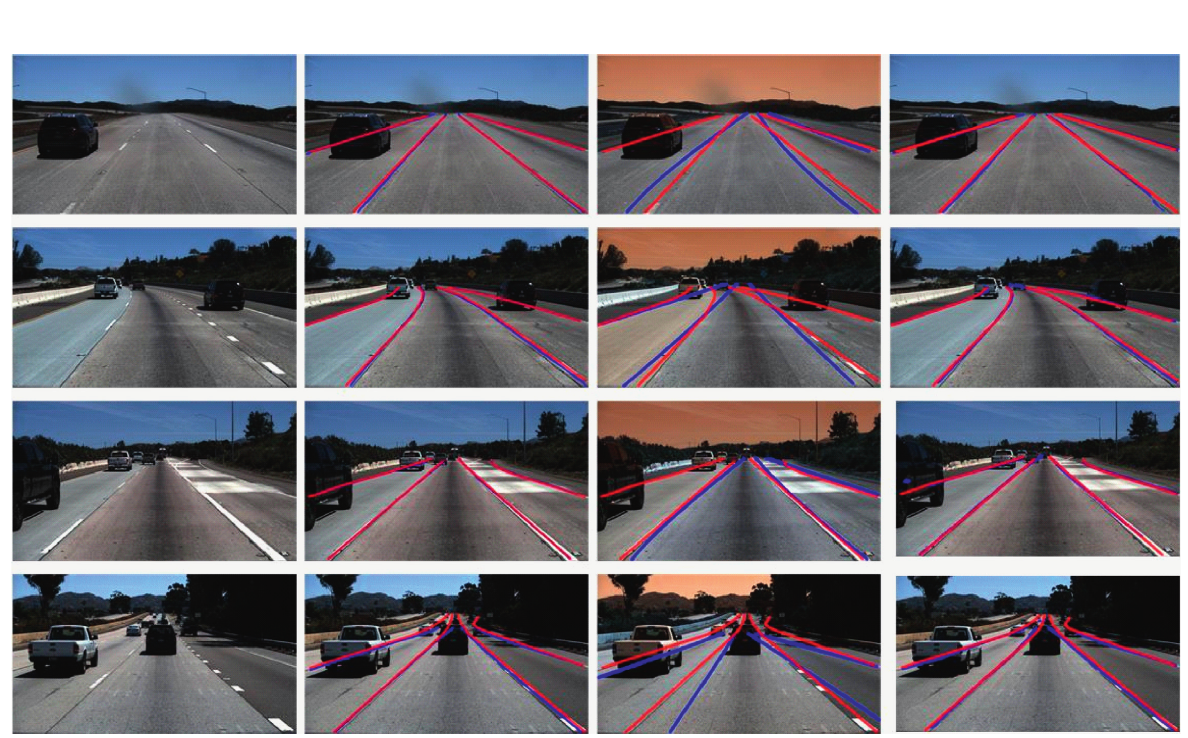
Figure 8: Visualization of lane detection results with comparative methods, the picture from left to right is the original pictures, results from RESA, results from PolyLaneNet, and results of proposed method. Red and blue lines denote ground truth and prediction lane,